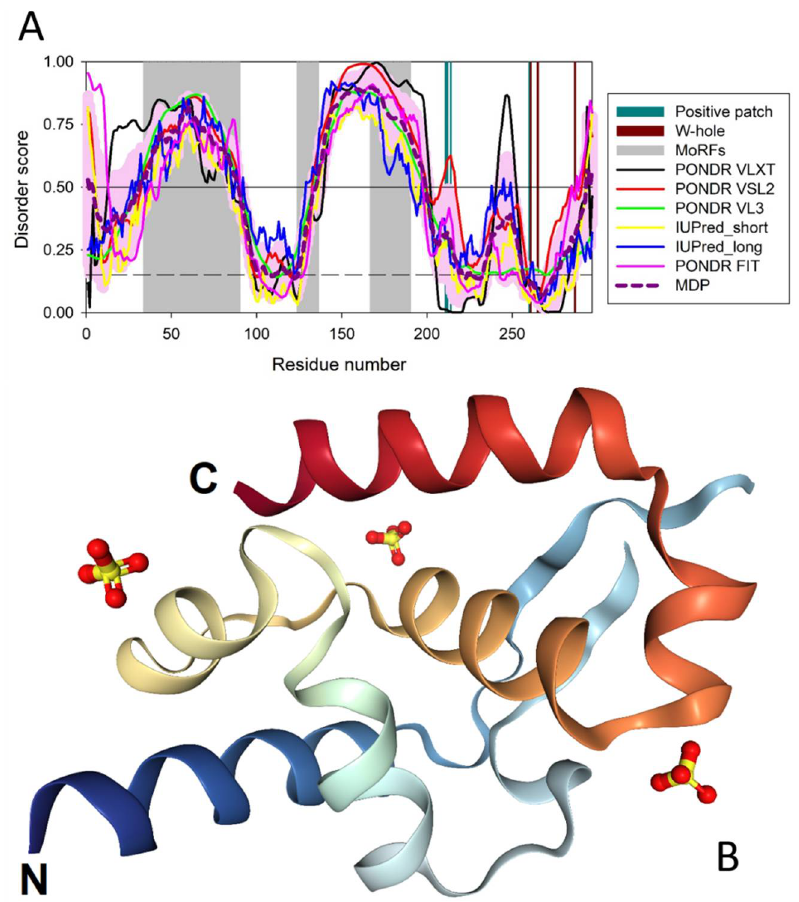
Figure 2. Structure and disorder in the RABV P-protein (UniProt ID: P06747). ( A ) Intrinsic disorder profile generated using data aggregated by the RIDAO platform. The profile also contains disorder/flexibility-related functional annotations and shows three predicted MoRFs (gray-shaded areas), positive patch residues (dark-cyan vertical bars), and W-hole residues (dark-red vertical bars). ( B ) Crystal structure of the C-terminal region of the RABV P-protein (residues 192–295) (PDB ID: 3OA1).